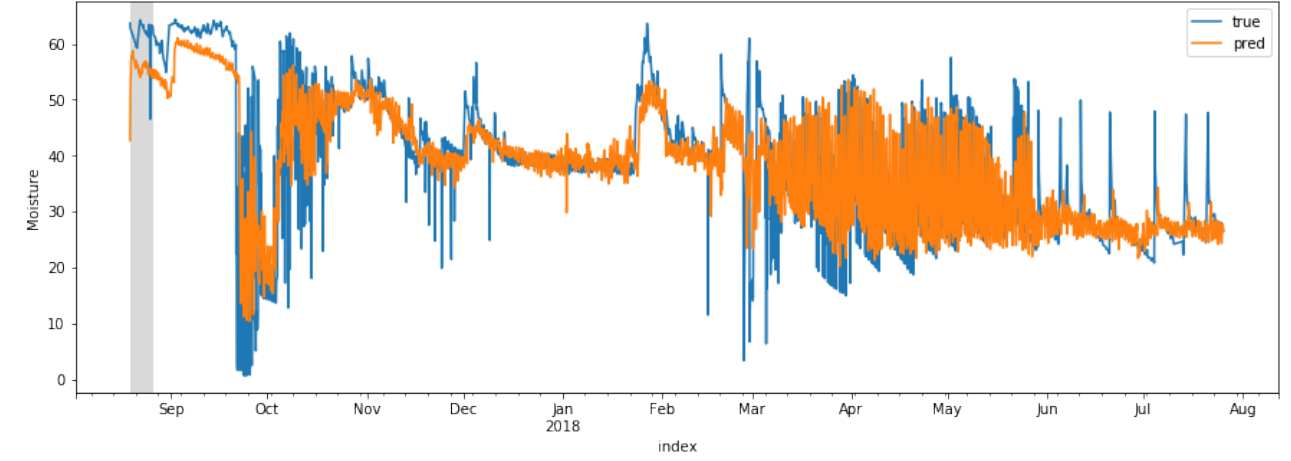
Figure 8. Plot of true (blue curve) and predicted (orange curve) readings of moisture. For modeling a neural sensor, a forecasting function is designed which take date as an object to forecast temperature, humidity and soil moisture against that particular date and time, the essential parameter for object (date) is time delta. Time deltas are differences in times. After training of LSTM network, the forecast values of temperature, humidity and soil moisture by neural sensor are shown in Figures 9–11, respectively. The blue-colored graph shows the value of the physical sensor embedded in the field and orange curve in the graph is the plot of predicted value of neural sensor that is obtained after the training of the LSTM model. Figures 9–11 further confirms the generalization of the proposed neural sensor model and illustrates its potential to be used to complement the physical